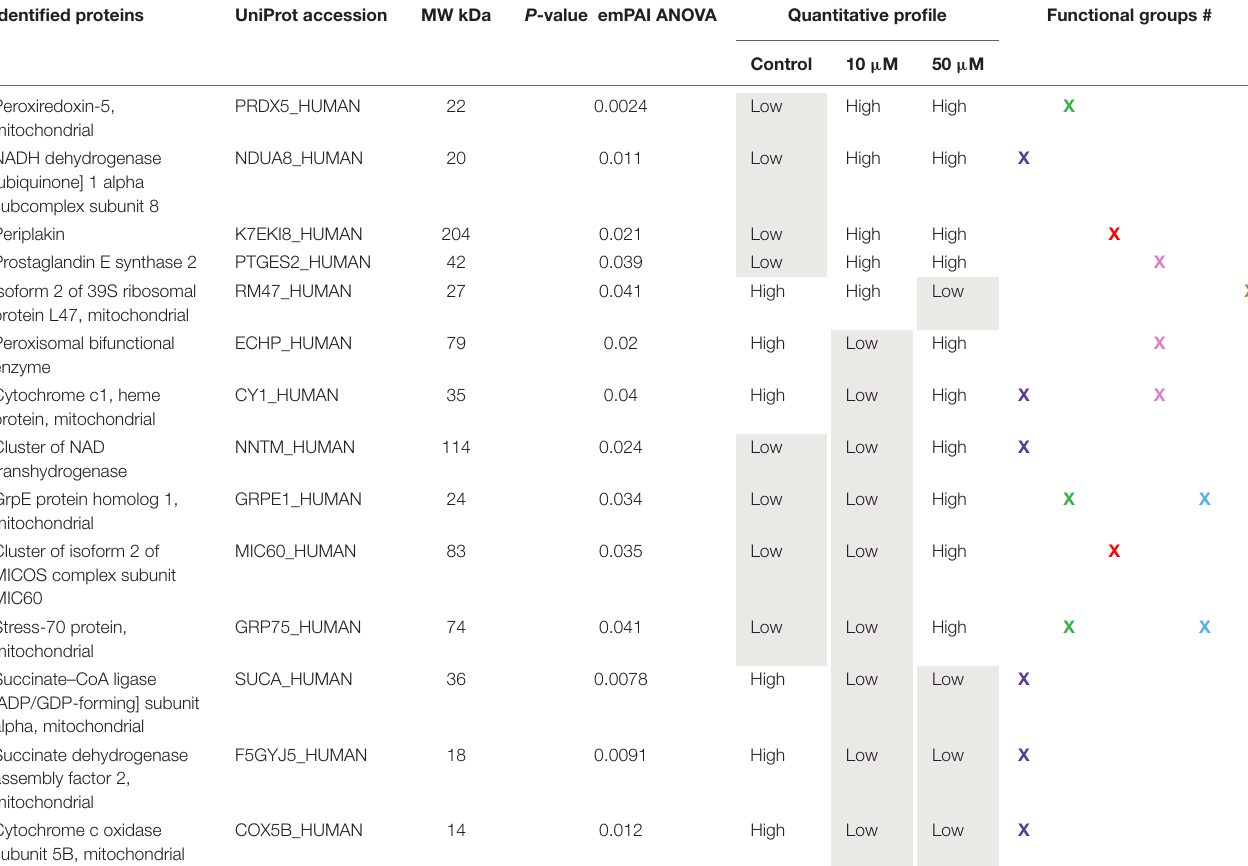
TABLE 2 | Differentially expressed mitochondrial proteins in Caco-2 epithelial monolayers after treatment with 10 or 50 µ M 3O-C 12 -HSL for 4 h compared to the diluent control. Identified